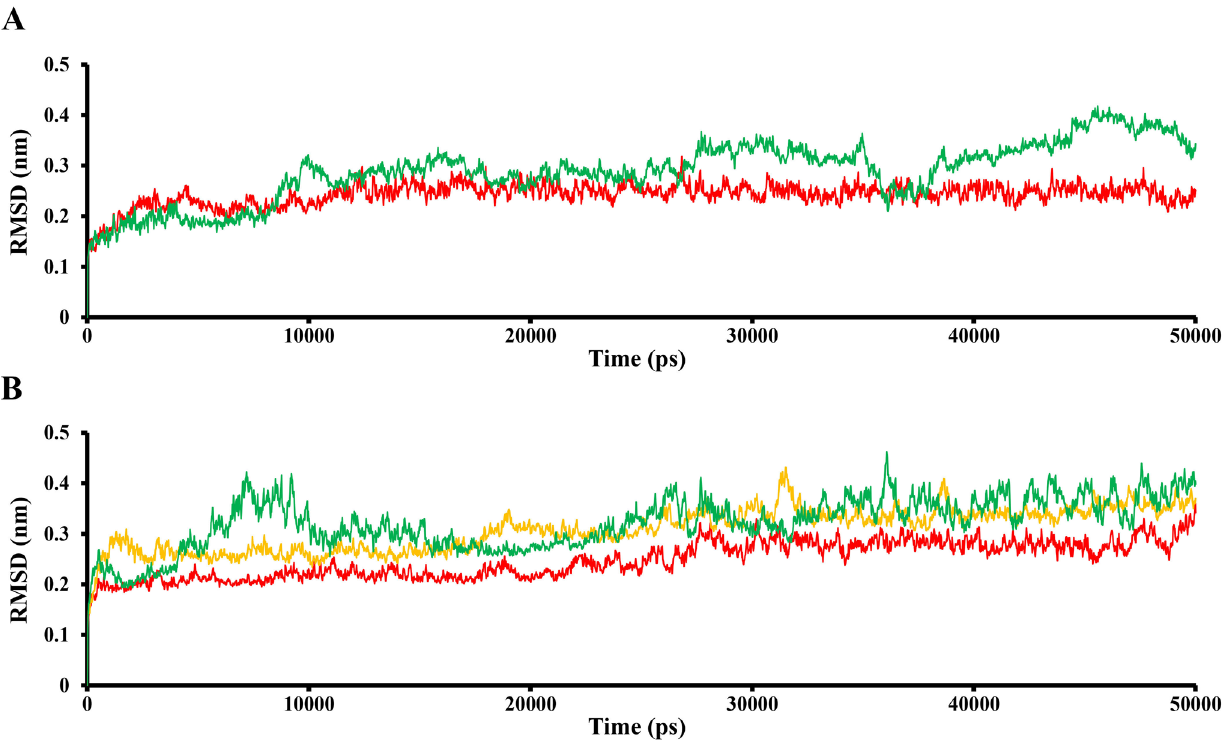
Figure 5. RMSD trajectories of 3CLpro ( A ) and RdRp ( B ) complexes with C 60 fullerene: 3CLpro free protein molecule—green, “C